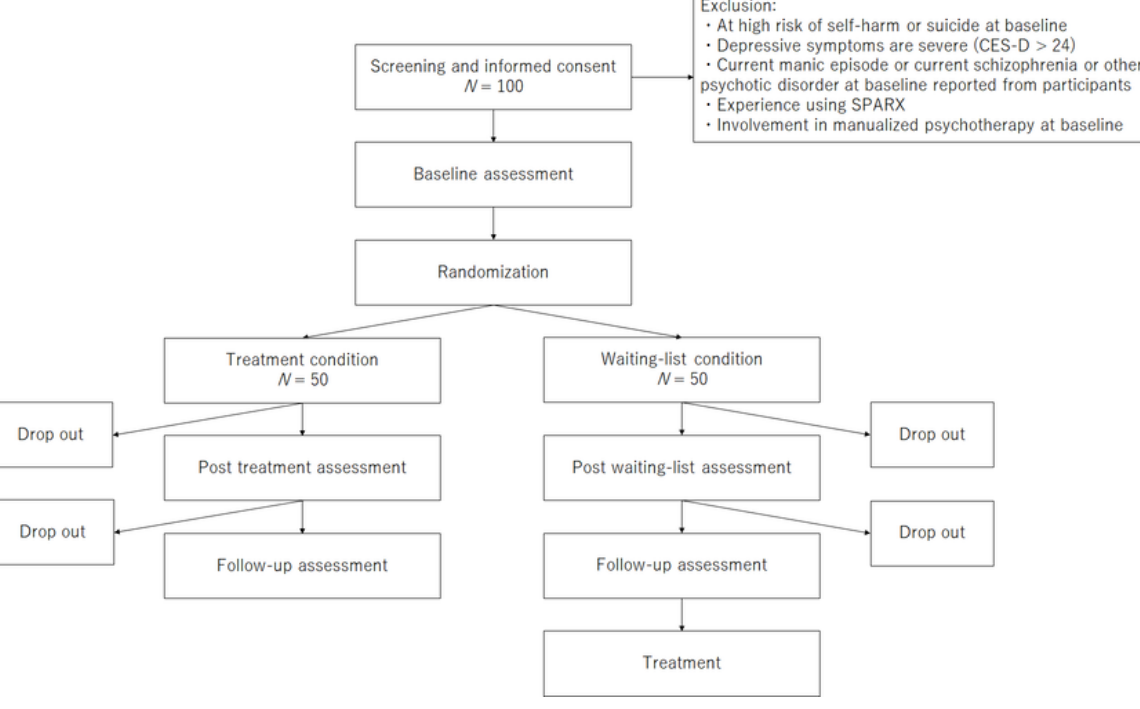
Figure 1. Participant flow of this trial. CES-D: Center for Epidemiological Studies Depression; SPARX: Smart, Positive, Active, Realistic, X-factor